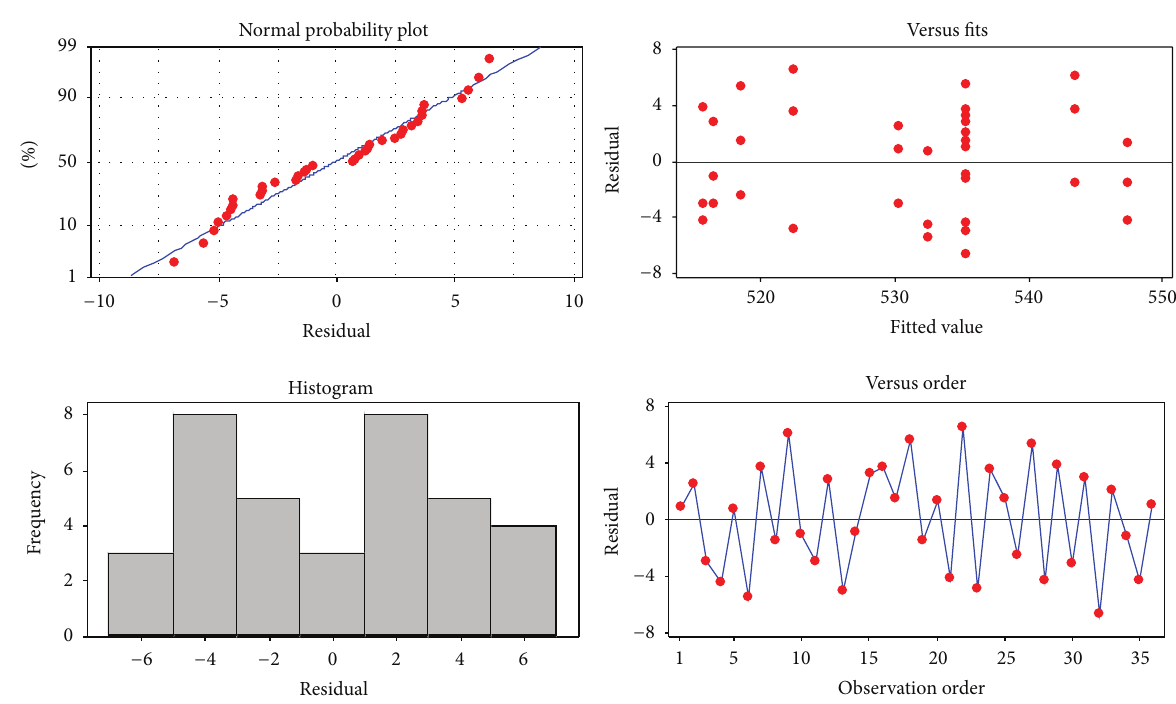
Figure 1: Residual plot for tensile strength from mathematical model checking.